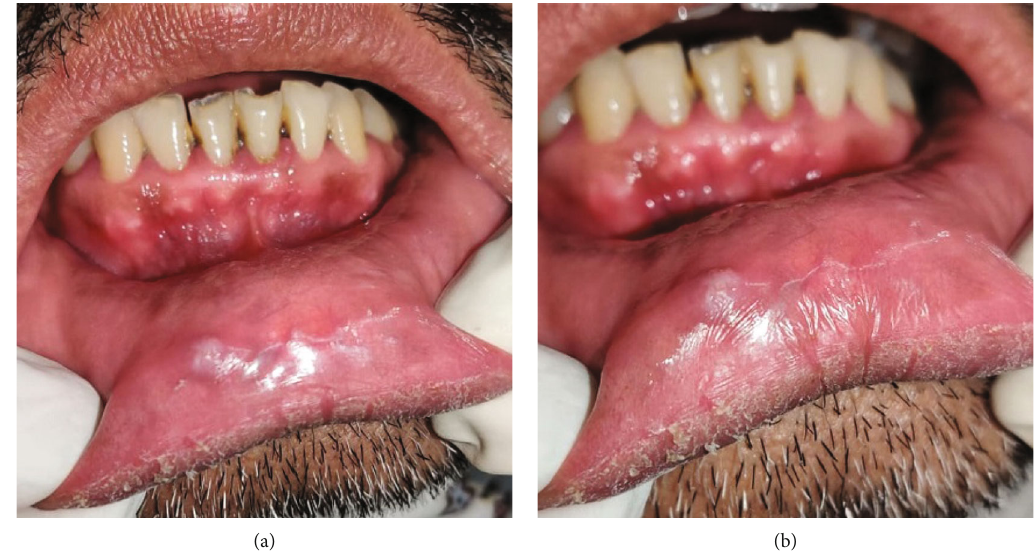
Figure 1: (a, b) Solitary, well-circumscribed submucosal mass in the lower lip, with an adjacent bluish-white swelling depicting a mucocele.